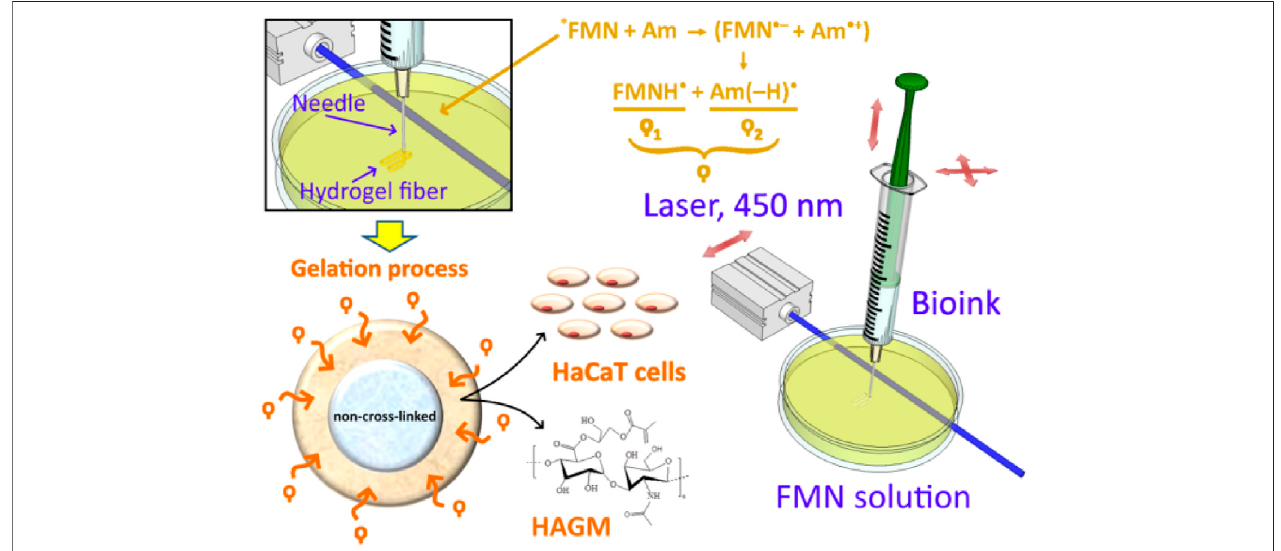
FIGURE 3 | Fabrication process of hollow-core hydrogel fi bers by “ diffusion-limited photofabrication approach ” . *FMN represents the exited triplet state of FMN (cid:129) – (cid:129) + molecule; Am: amine; (FMN ): semi-reduced fl avin; and (Am ): semi-oxidized amine. Ϙ represents a long-living species Ϙ 1 and Ϙ 2 , where Ϙ 1 is fl avin neutral radical (cid:129) (cid:129) (FMNH ) and Ϙ 2 is amine neutral radical [Am ( – H)